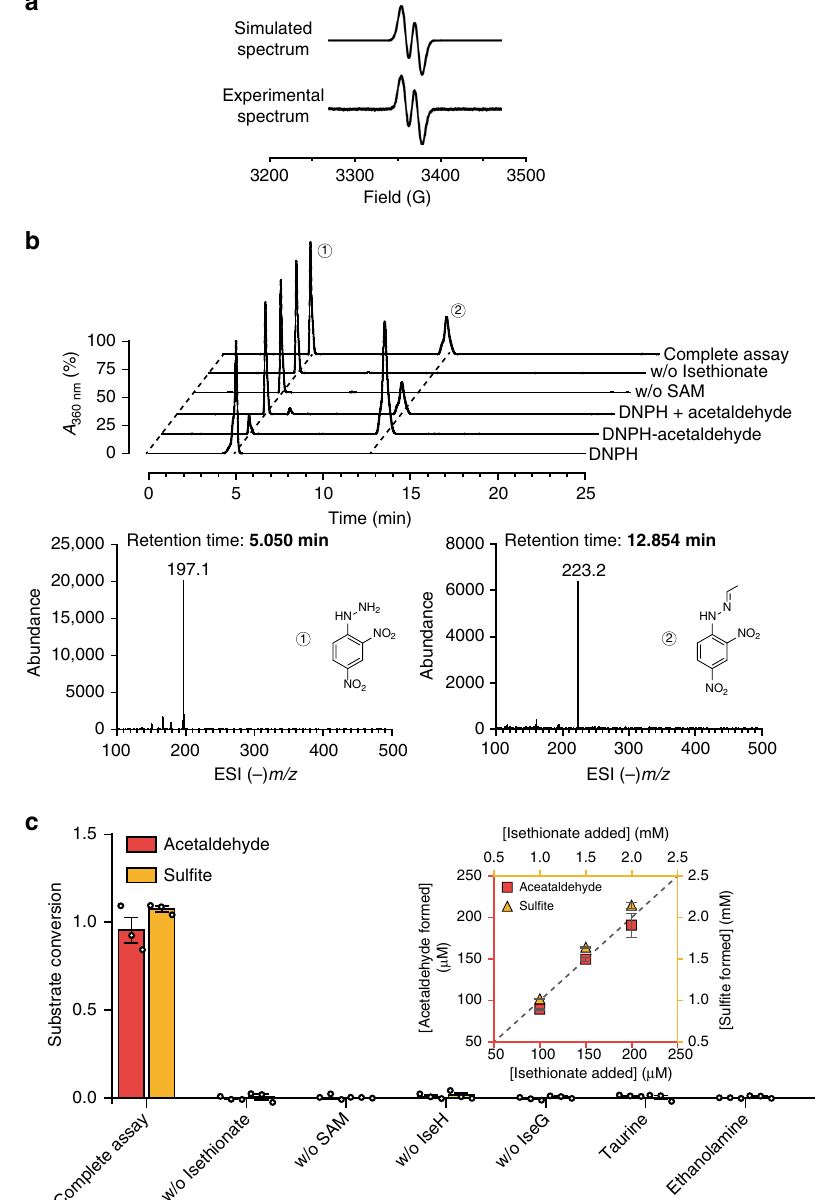
Fig. 2 EPR spectra and enzymatic assays. a X-band EPR spectrum of IseG reconstituted with IseH and SAM in the presence of reductant (Ti (III) citrate). b Detection of acetaldehyde formation in the IseG-catalyzed isethionate cleavage using LC-MS/MS. HPLC elution pro fi les of the DNPH derivatives from the reaction products, reaction negative controls, and authentic standards (theoretical mass of the monoanion of DNPH = 197.1, and DNPH-acetaldehyde = 223.2), are presented. Negative ionization mass spectra of the peaks 1 and 2 from the HPLC trace show that they contain DNPH and DNPH- acetaldehyde, respectively. c Enzymatic assays showing the fraction of substrate converted to acetaldehyde and sul fi te under different reaction conditions, demonstrating the reaction requirements and substrate speci fi city. The inset shows the stoichiometric conversion of isethionate into acetaldehyde and sul fi te. The error bars represent the standard deviation of three individual experiments. Source data are provided as a Source Data fi